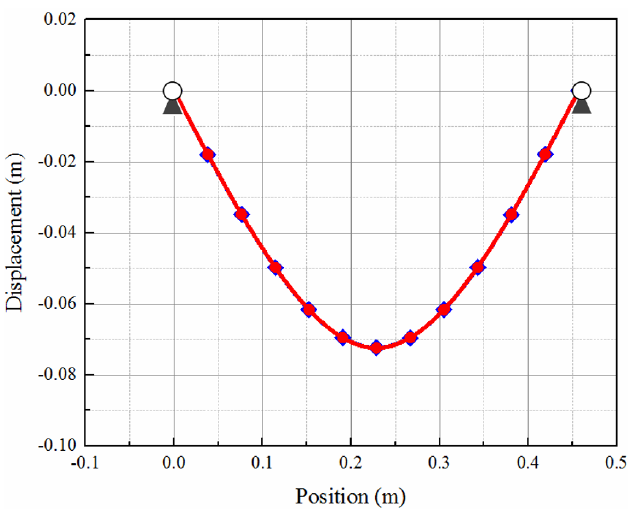
Figure 4. Deformed shape of the beam. ( CB method (free-free modes) and ANSYS (simply-supported modes)).